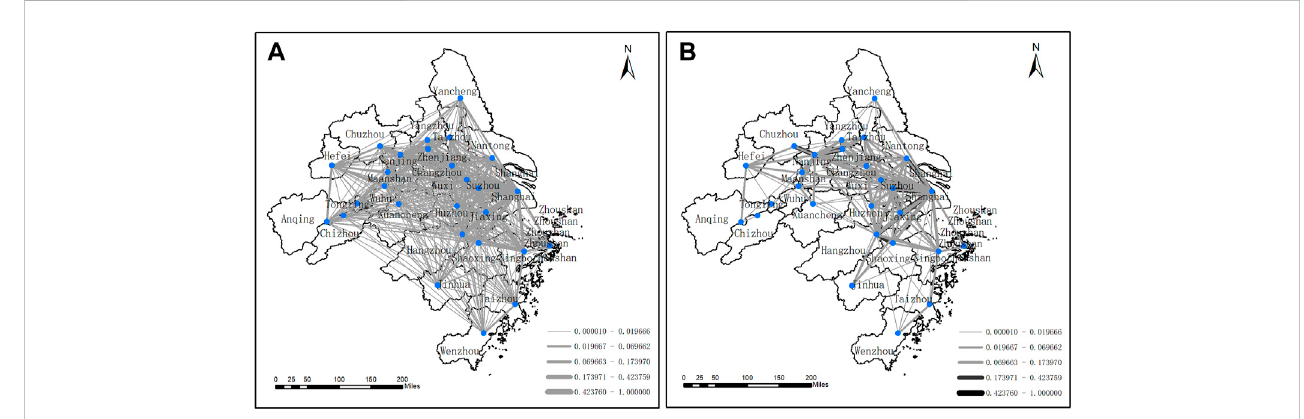
FIGURE 3 Strength of economic ties in the Yangtze River Delta city cluster in 2020 (A,B) .